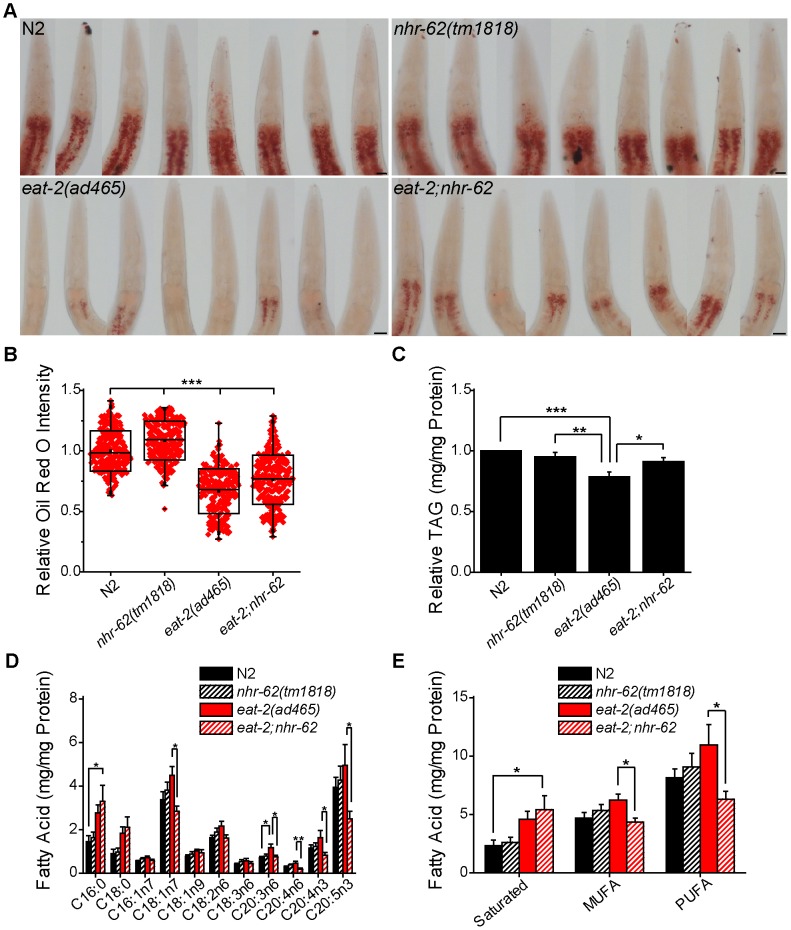

nhr-62 modulates DR-induced fat metabolism.(A) Representative pictures of Oil Red O stained worms. Scale bar = 20 µM. (B) Oil Red O intensity is increased relative to wild-type (N2) or eat-2(ad465) controls by mutation of nhr-62 (combined data from 3 independent experiments). (C) Total triglycerides of day 1 adults relative to wild-type (N2) (combined data from 16 independent experiments). (D) Fatty acid profiles of day 1 adult animals (combined data from 11 independent experiments). (E) Total saturated, monounsaturated fatty acid (MUFA), and polyunsaturated fatty acid (PUFA) calculated from (D). eat-2;nhr-62 had increased saturated fat compared to wild-type (N2) and decreased MUFAs and PUFAs compared to eat-2(ad465). See Figure S3 for physiologic traits of nhr-62 mutation. *p<0.05, **p<0.01, ***p<0.001 by single factor ANOVA with Tukey test. Mean (Center Line) ± SD (Box) with bars representing an outlier coefficient of 1.5, or Mean±SEM.